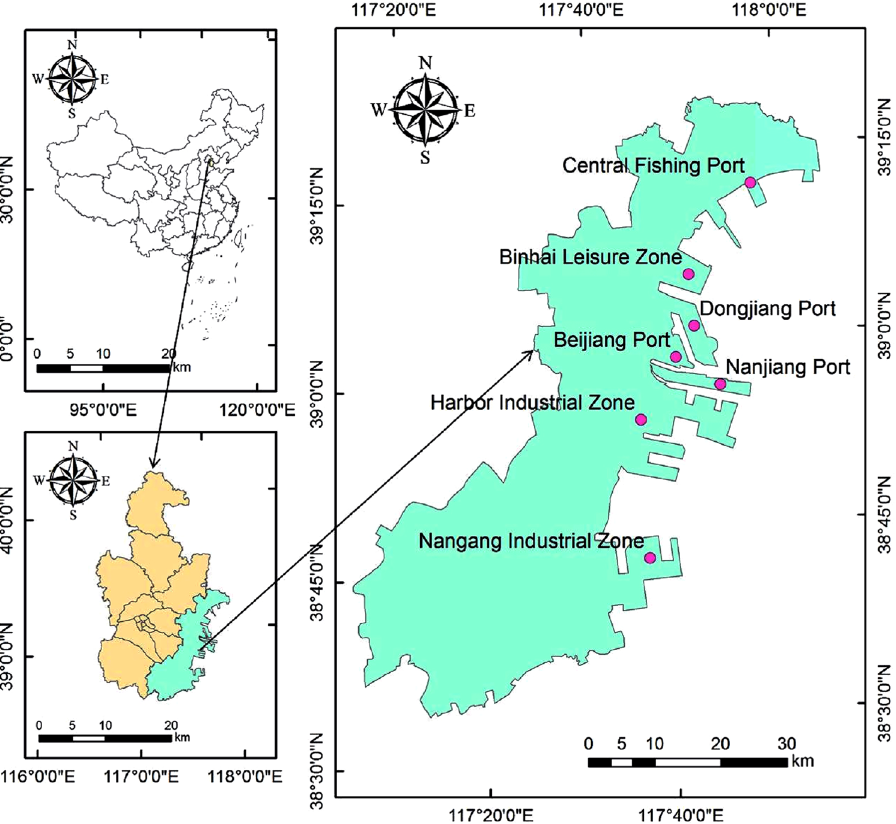
Figure 5. Location of Tianjin Binhai New Area. Figure 5 was generated by ArcGIS v10.2 software (Environmental Systems Research Institute, Inc, USA, URL